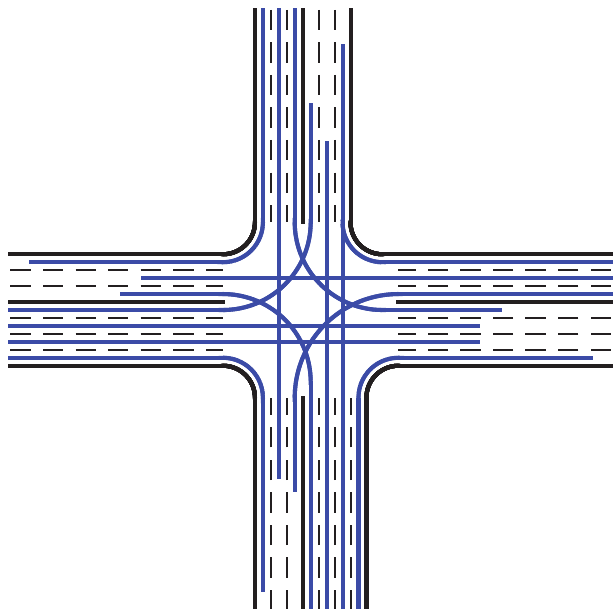
Figure 17. VPs at